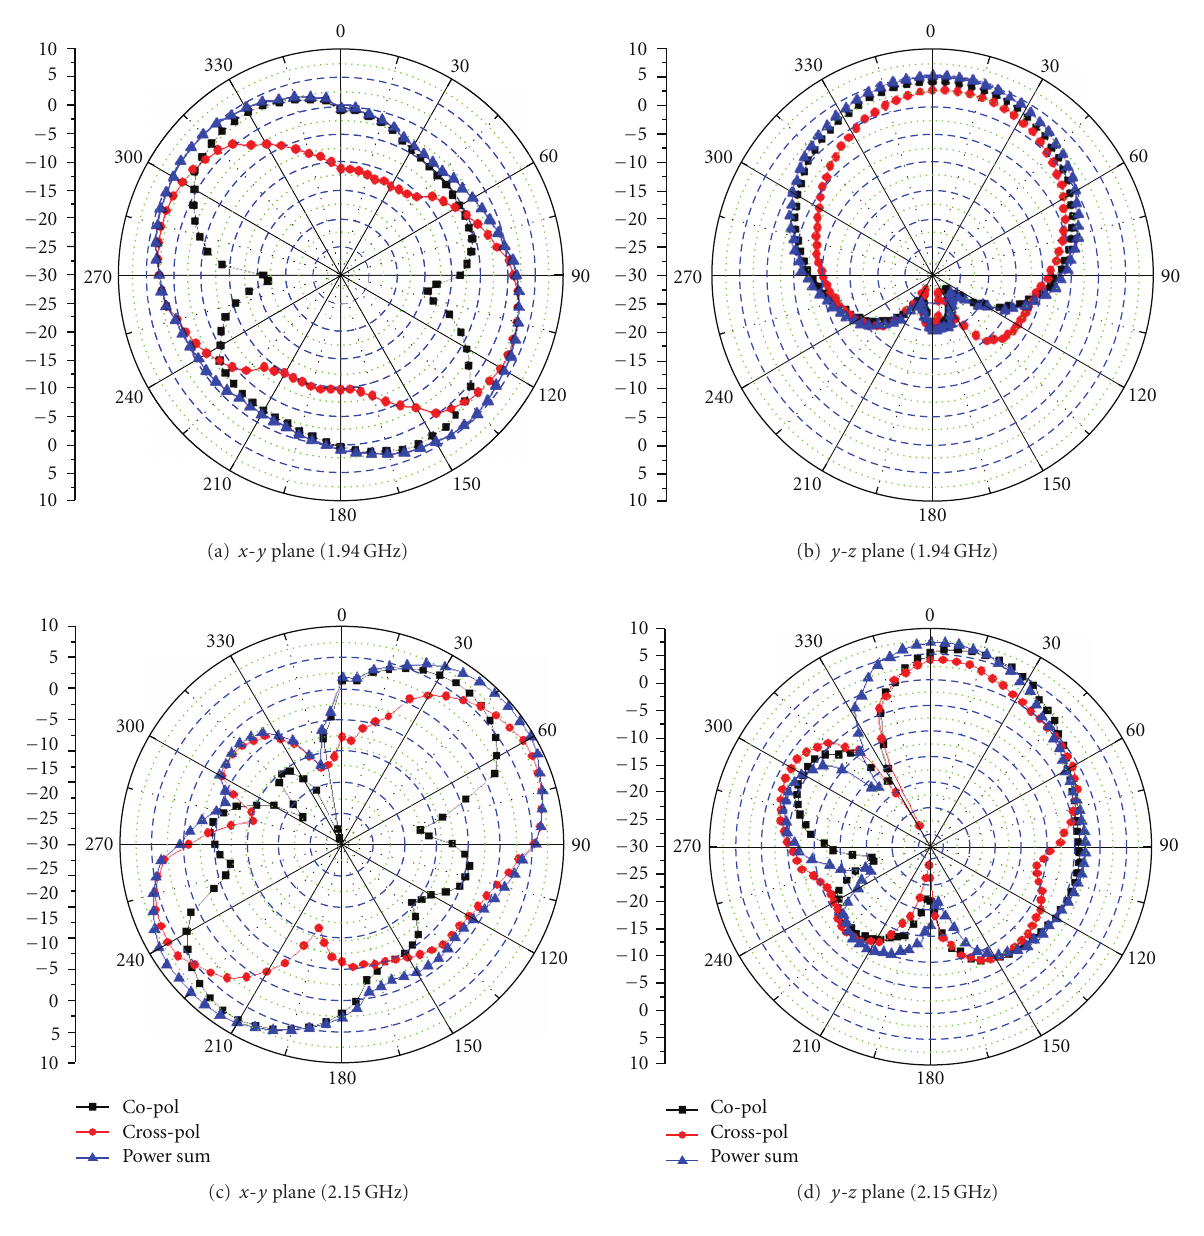
Figure 11: Measured far-field radiation patterns of the fabricated